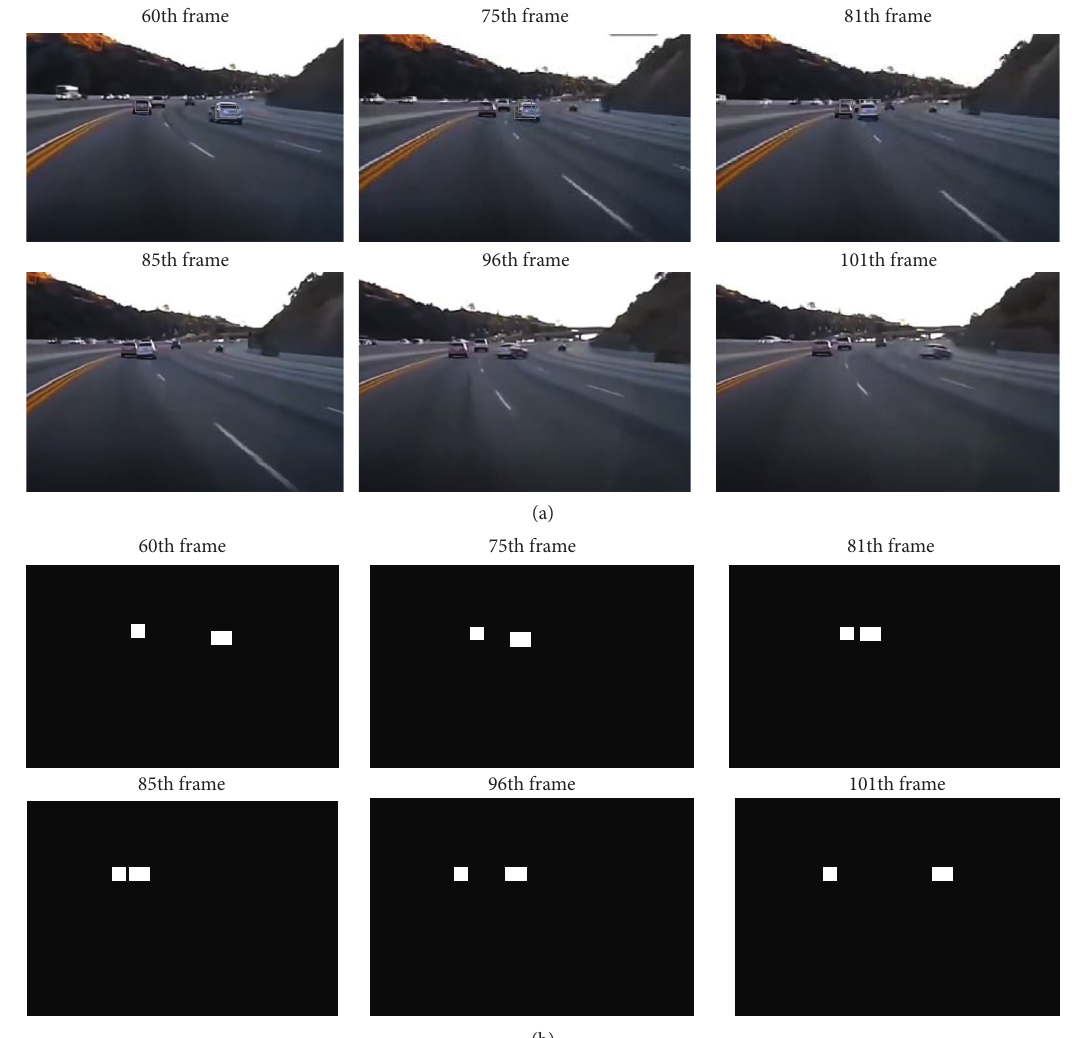
Figure 11: The sum of the original image (a) and the foreground image (b) of the multivehicle detection and tracking results on the the dashed line represents the center of mass of the vehicle.